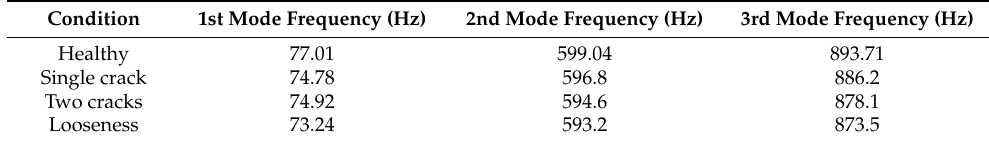
Table 1. Resonance frequency values of rotating blades.